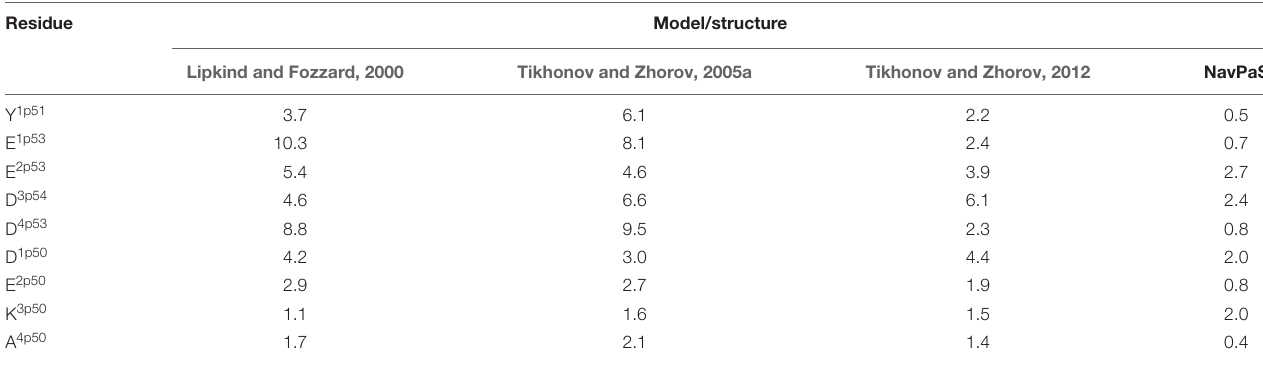
TABLE 1 | Deviations (Å) of central atoms of TTX-binding functional groups in homology models and NavPaS from matching atoms in the Nav1.4 cryo-EM structure.